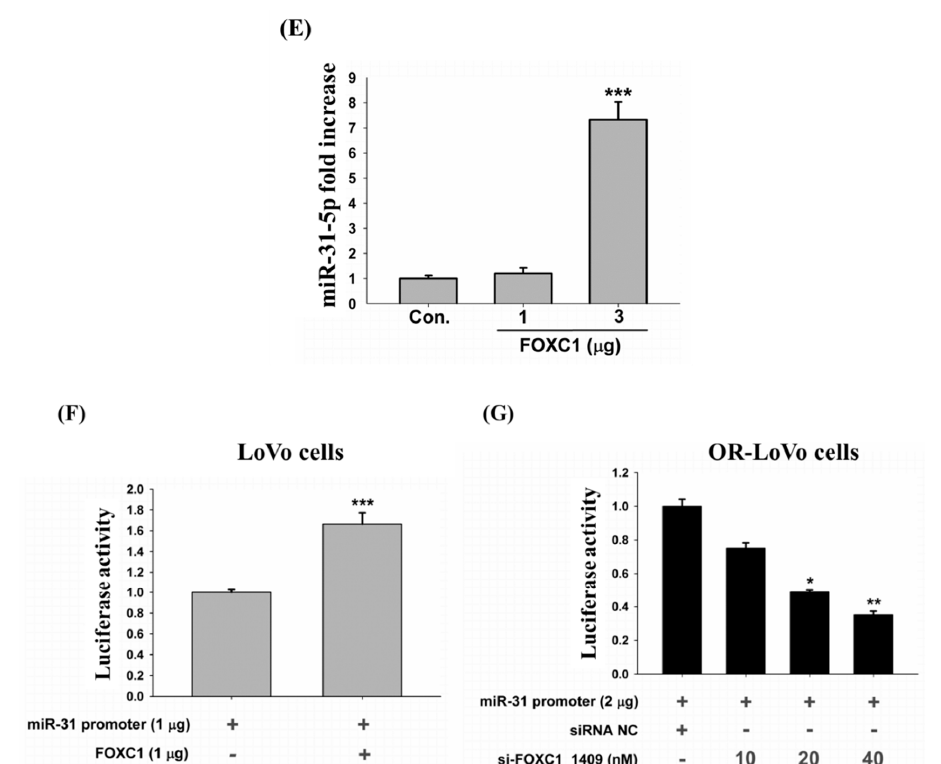
Figure 7. FOXC1 transcription factor binds to the miR-31 promoter and induces high miR-31-5p expression. ( A ) FOXC1 protein levels after the transfection of two different FOXC1 siRNAs in OR- LoVo cells. ( B ) MiR-31-5p levels in FOXC1-siRNA-transfected OR-LoVo cells. ( C ) FOXC1 mRNA expression following transfection of two doses of the FOXC1 overexpression construct (1 and 3 μ g) in LoVo cells. The fold increase is calculated by the ratio FOXC1/GAPDH, being GAPDH snRNA constitutively expressed ( D ) FOXC1 protein levels resulting from two doses of the FOXC1 overexpression construct (1 and 3 μ g) in LoVo cells. ( E ) MiRNA-31-5p expression resulting from two doses of the FOXC1 overexpression construct (1 and 3 μ g) in LoVo cells. The fold increase is calculated by the ratio miR-31-5p/U6, being U6 snRNA constitutively expressed. ( F ) The luciferase reporter assay confirmed that LoVo cells were co-transfected with the miR-31 promoter (1 μ g) and FOXC1 overexpression construct (1 μ g). ( G ) The luciferase reporter assay confirmed that OR-LoVo cells were co-transfected with the miR-31 promoter (2 μ g) and various concentrations of FOXC1-siRNA 1409 (0, 10, 20, and 40 nM). * p < 0.05 vs. control group; ** p < 0.01 vs. control group; *** p <0.001 vs. control